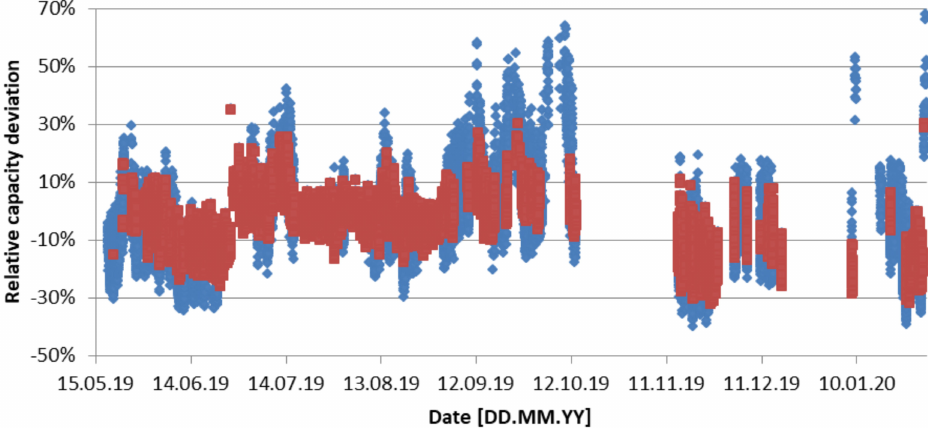
Figure A2. Trend of relative decrease of cooling tower power (calculated minus measures divided by measured) of dataset CT1-Eval2 calibrated with dataset CT2-Cal2; blue dots: all data, red dots: only 100% fan